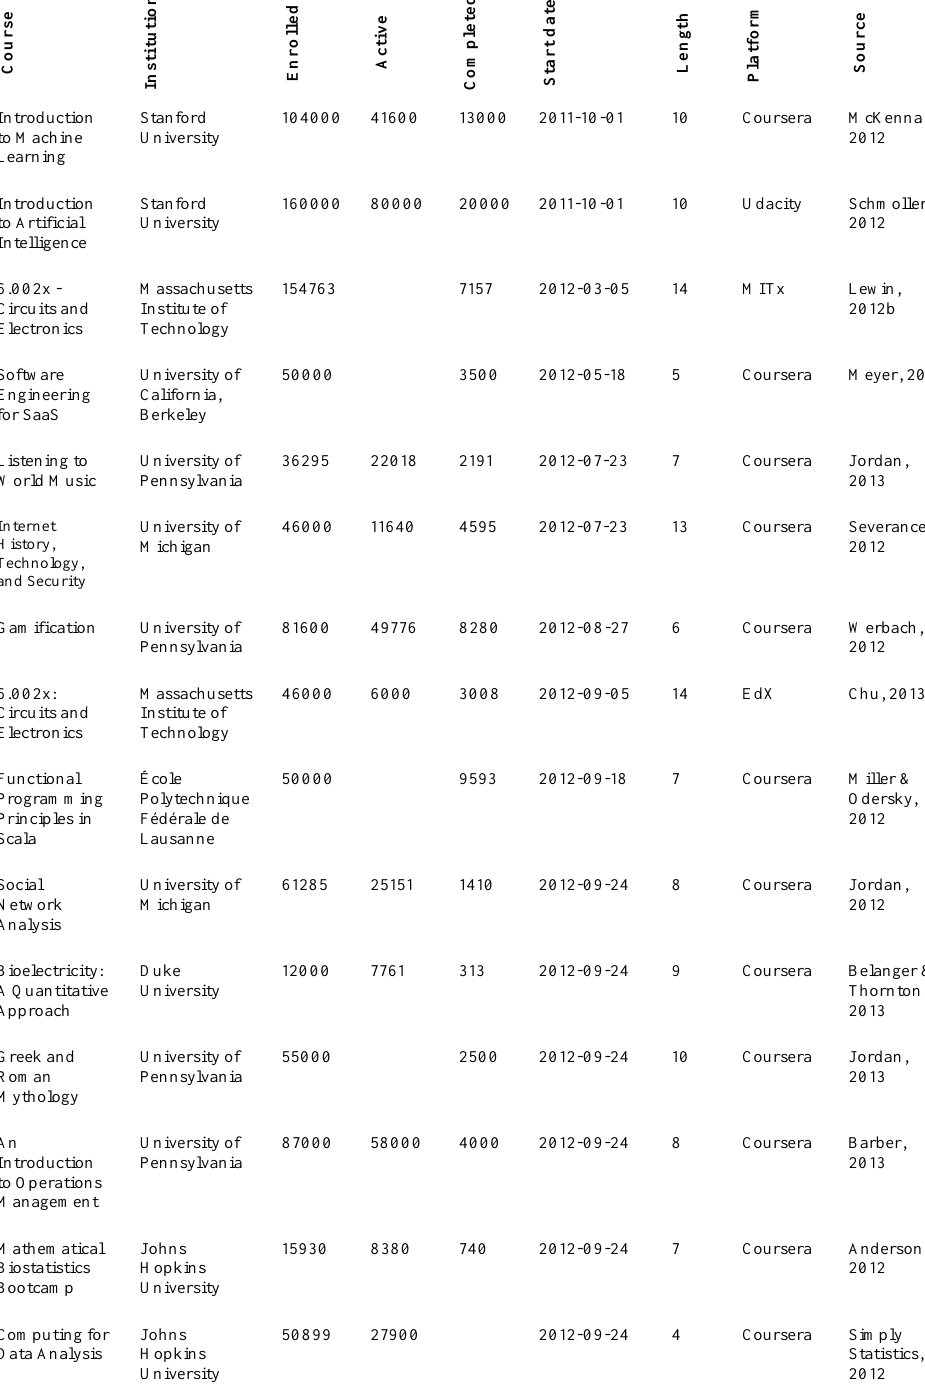
Table 2: Data Drawn from Online Sources in Relation to MOOC Enrolment, Number of Active Users, and Completion